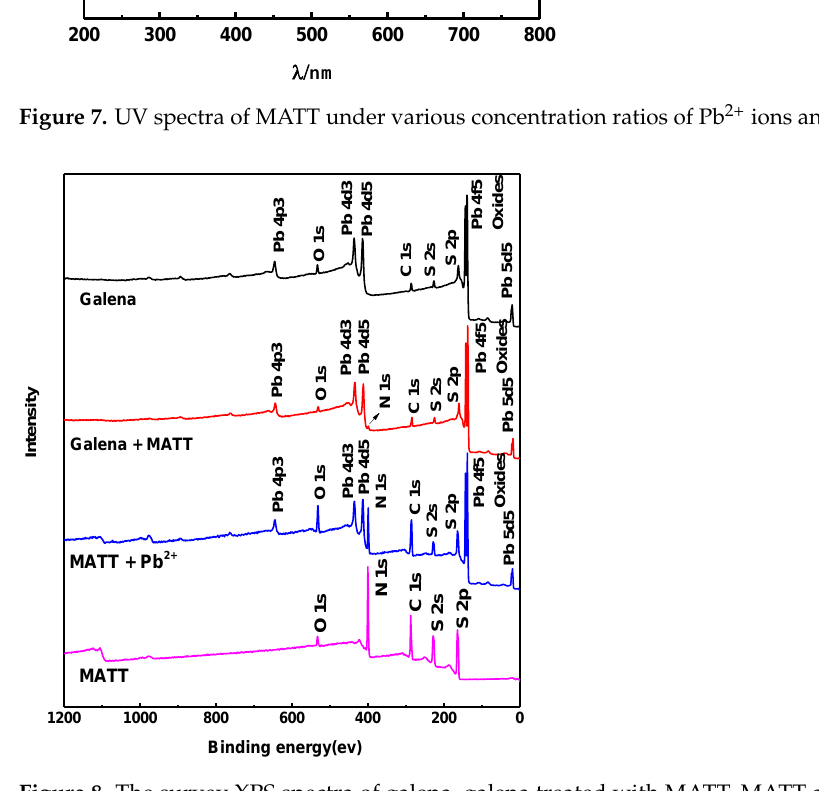
Figure 7. UV spectra of MATT under various concentration ratios of Pb 2+ ions and MATT.